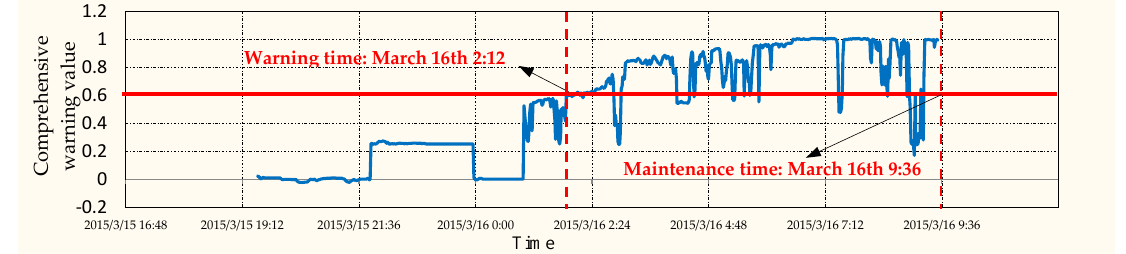
Figure 10. Warning figure in best warning threshold.